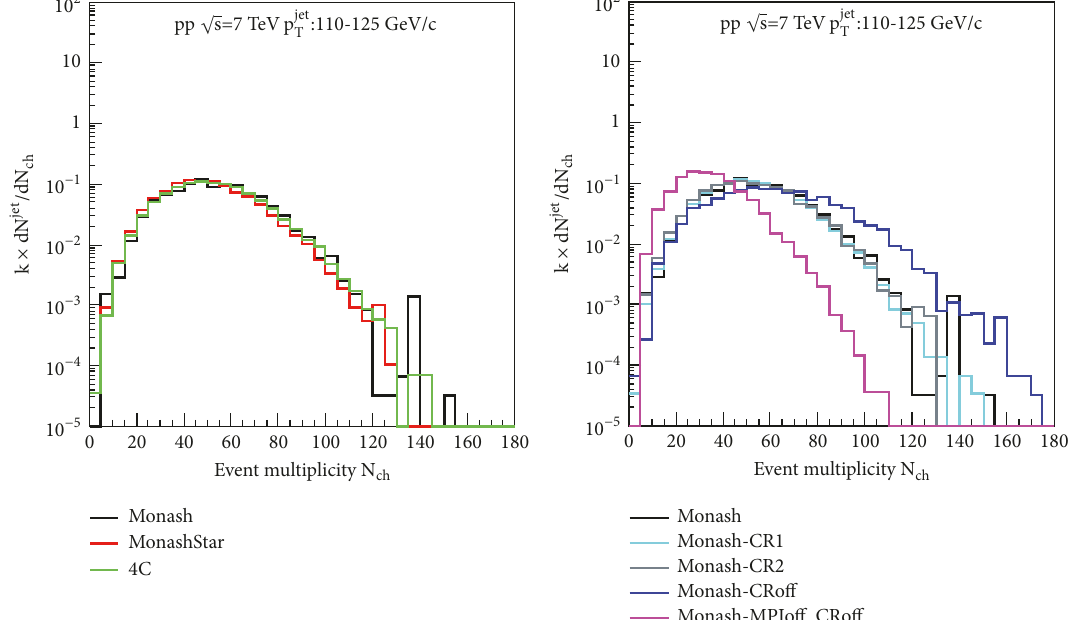
< 125 GeV /𝑐 window, compared for the Monash, Monash ∗ , T